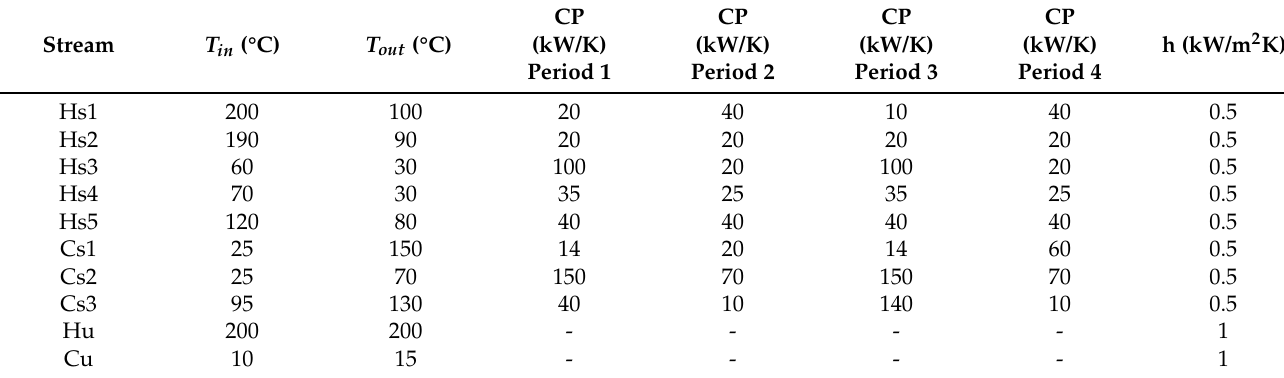
Table 1. Stream data and cost coefficients for case